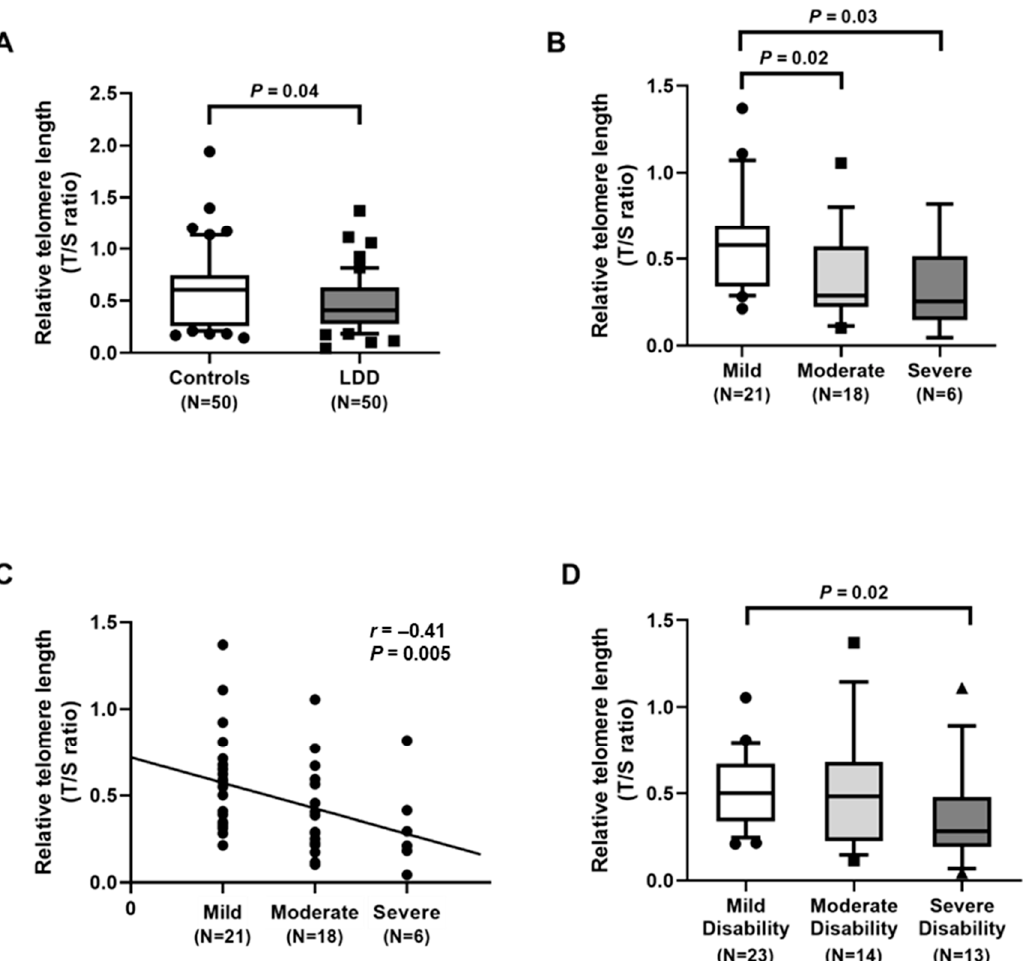
Figure 1. Determination of relative telomere length (RTL): ( A ) comparison of RTL in lumbar disc degeneration (LDD) patients and controls. Circles represent control group, squares LDD group; ( B ) comparison of RTL in LDD, based on the radiographic severity. Circles represent mild group, squares moderate group; ( C ) correlation of RTL and the radiographic severity. Circles represent individual data points; ( D ) comparison of RTL in LDD, stratified by Oswestry disability index score. Circles represent mild group, squares moderate group, triangles severe group.